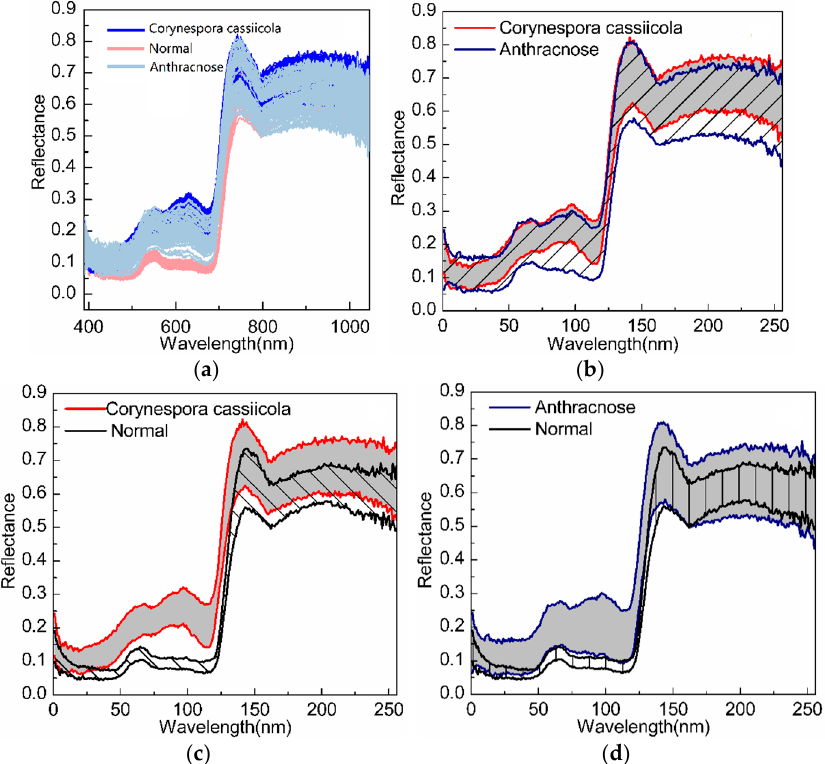
Figure 5. The coverage areas of spectral curves corresponding to different diseases: (a ) normal, anthracnose and Corynespora cassiicola ; ( b ) anthracnose and Corynespora cassiicola ; ( c ) normal and Corynespora cassiicola ; ( d ) normal and anthracnose.